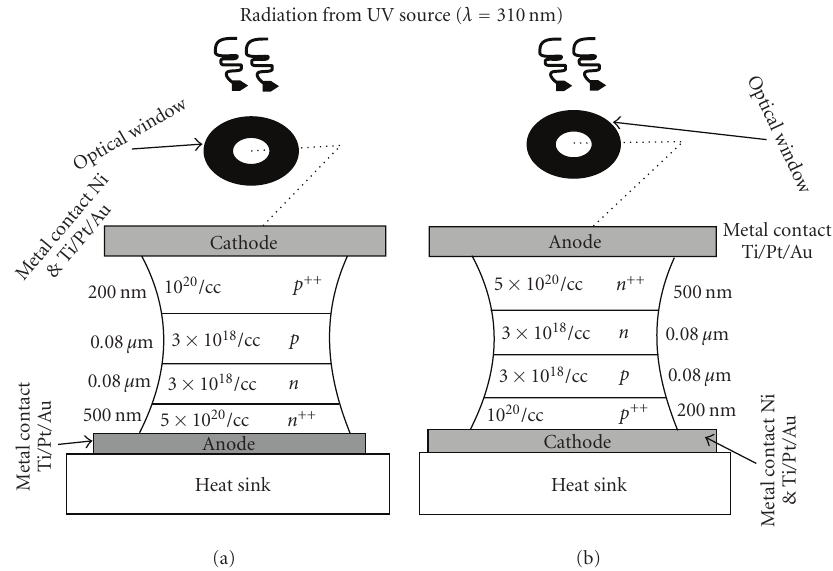
Figure 1: Schematic diagram of (a) top mounted and (b) flip chip DDR IMPATT diode under optical-illumination.